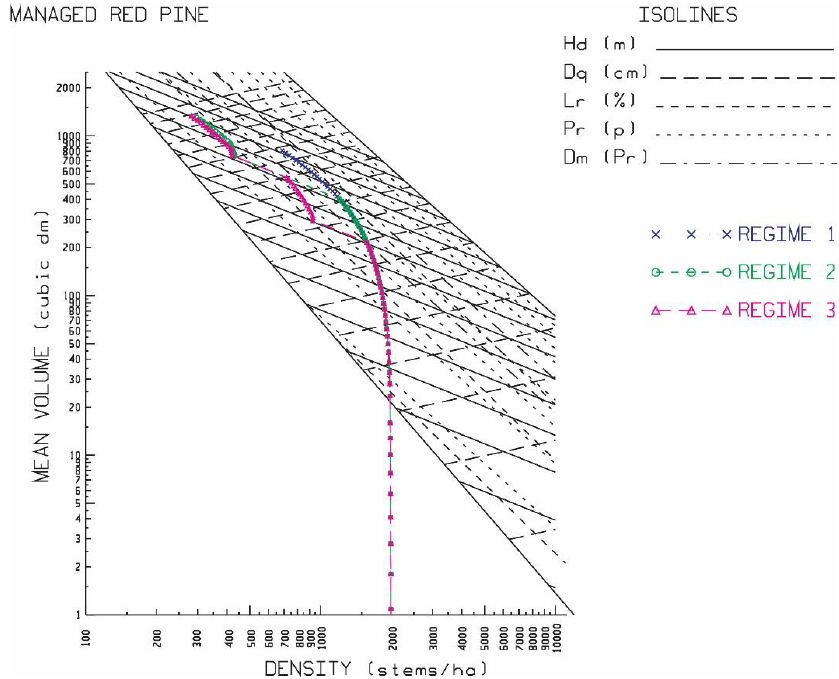
Figure 3. Temporal size – density trajectories for the three red pine plantations growing under conditions consistent with the RCP4.5 (Table 1) on a medium-to-good site quality ( S I = 23) situated in north-eastern Ontario (Kirkland Lake) as illustrated within the context of the SDMD graphic. Graphical denotations and regime specifics follow those defined in Figure 2 and Table 2, respectively.